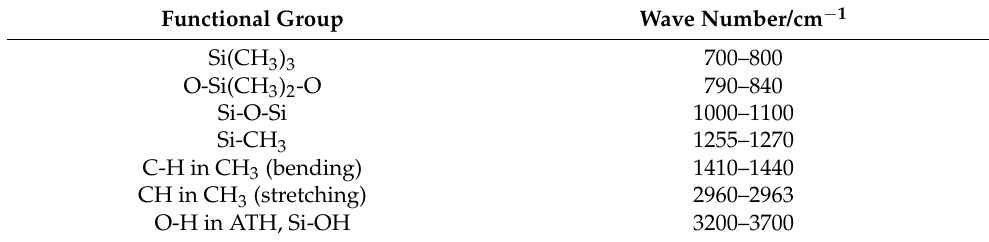
Table 1. FTIR absorption bands of HTV SIR material [5,18,20,23].